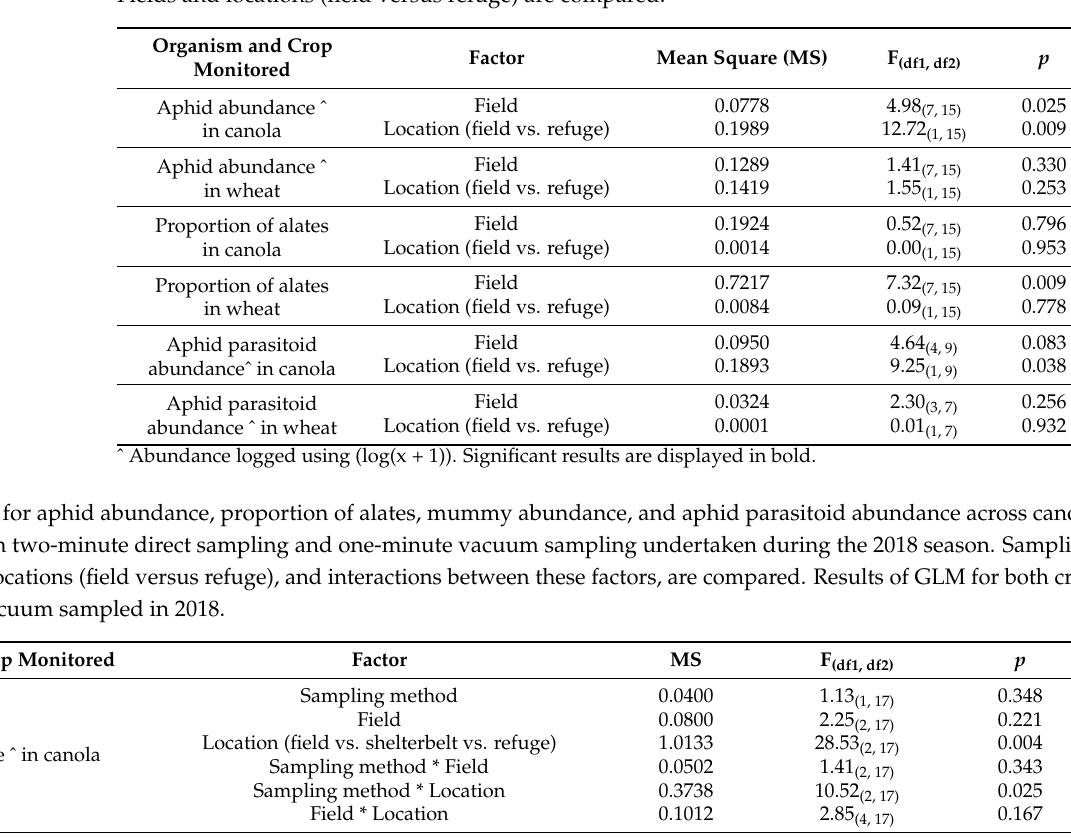
Table 2. GLM results for aphid abundance, proportion of alates, and aphid parasitoid abundance across canola and wheat fields from 24 h yellow pan trapping undertaken during the 2017 season. Fields and locations (field versus refuge) are compared.